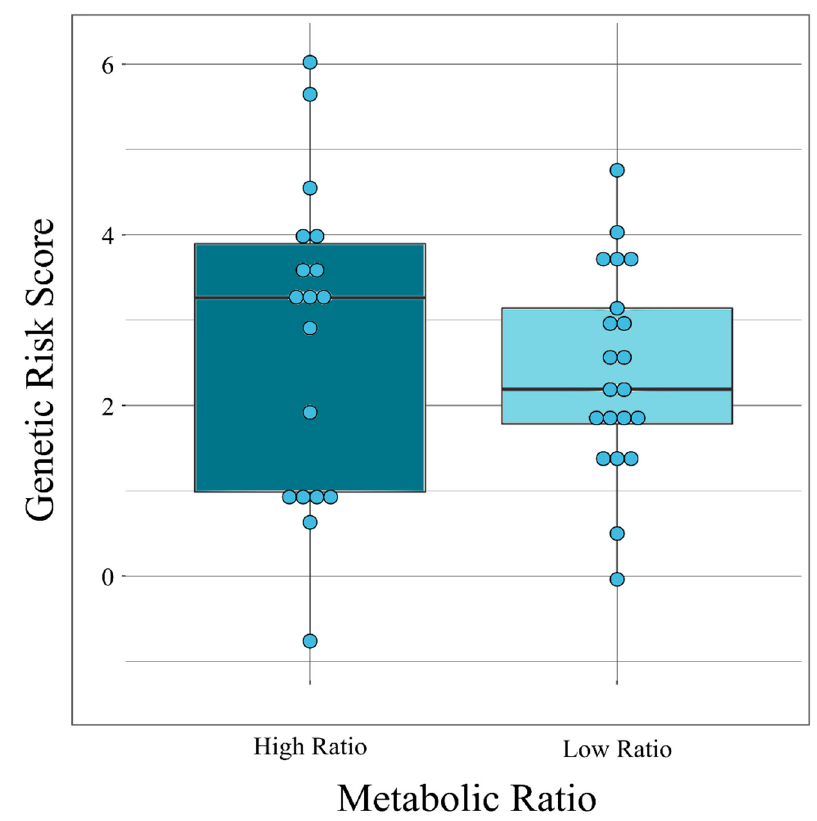
Figure 2. Subgroups of clozapine-treated patients according to their metabolic ratios and bipolar disorder genetic risk score. Box plot showing the distribution of values and the cut-off points for the metabolic ratios and genetic risk scores.